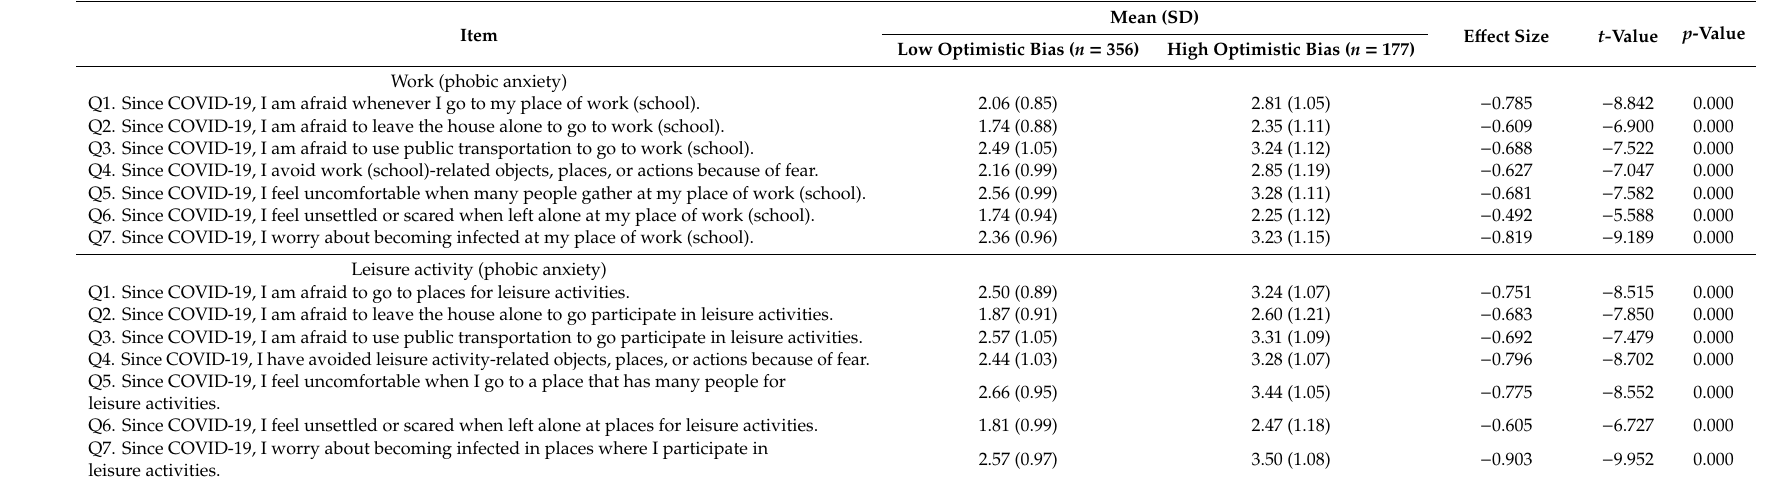
Table 2. Analysis of di ff erences in phobic anxiety according to optimistic bias ( n =